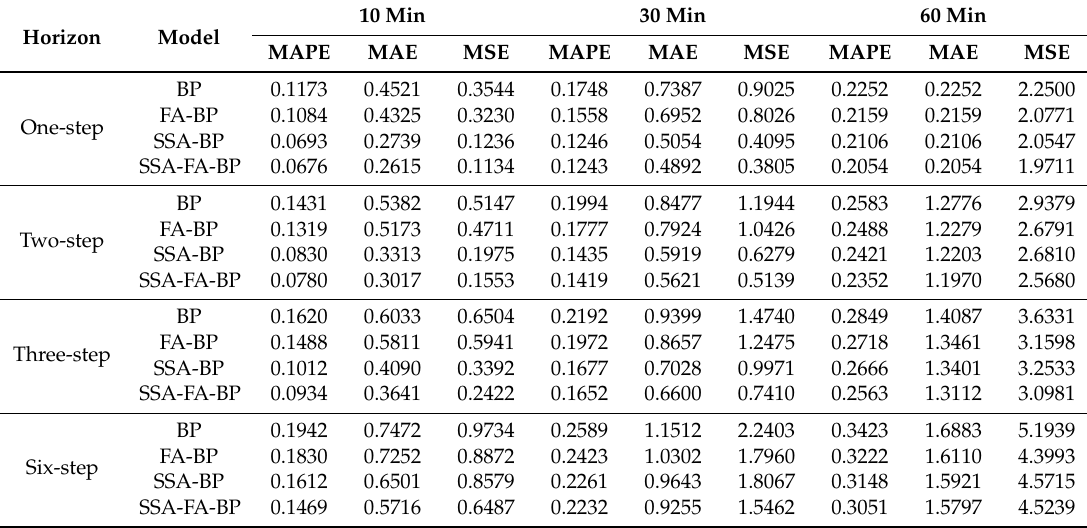
Table 9. The quarterly average forecast results of the combined model and the results of the other models involving the data of three units (three